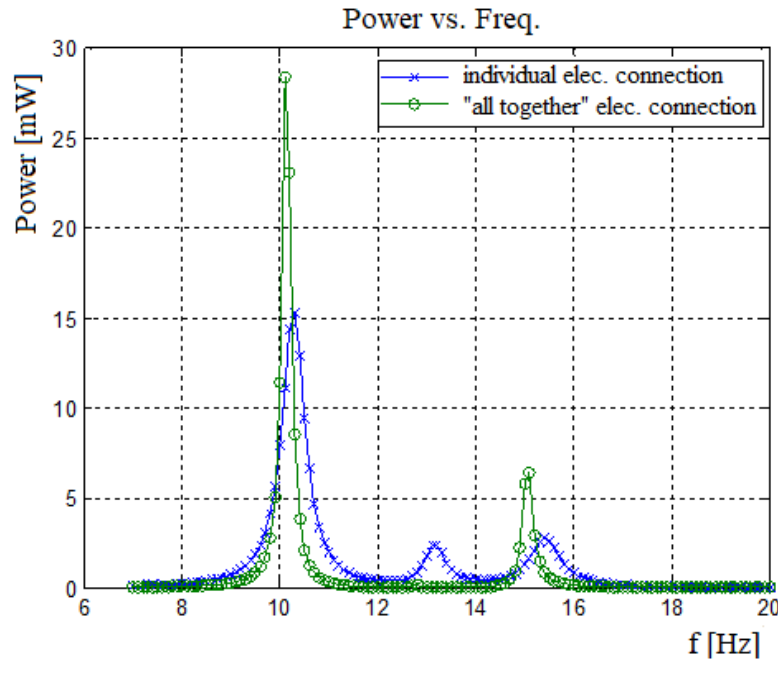
Figure 20. Power output for electrically individual connection vs. “all together” connected bimorphs—a three bimorphs system ( L = 50 mm, b = 30 mm, c = 0.1 mm, M 1 = 30 gr, M 2 = 60 gr, M 3 = 50 gr, K 1 = 40 N/m, and K 2 = 60 N/m).